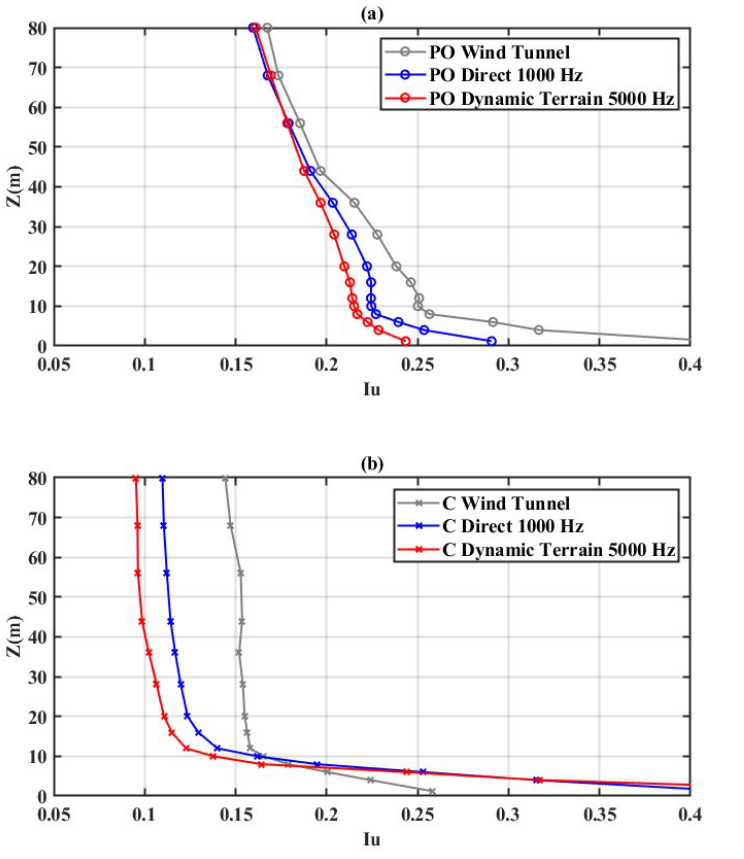
Figure 12. Turbulence intensity at ( a ) PO and ( b ) C as extracted from wind tunnel and calculated from dynamic terrain 5000 Hz and direct